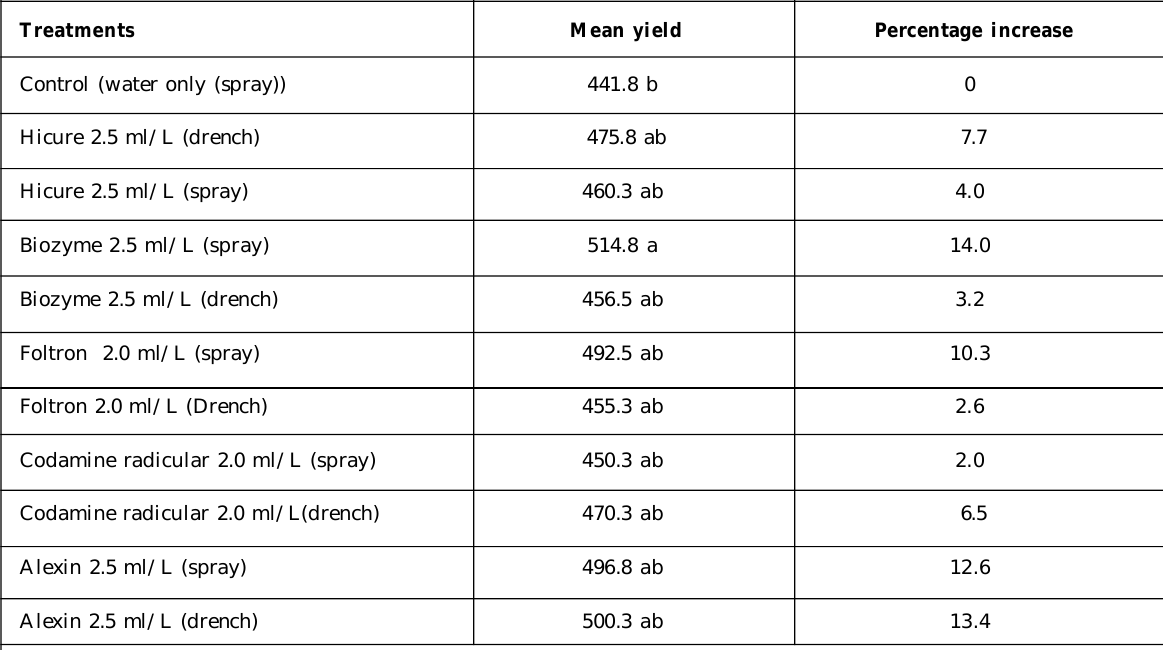
Table 2: Mean yield of roses and percentage increase on plots treated with hicure 2.5 ml/L, biozyme 2.5 ml/L, with water only (pooled data for one year)